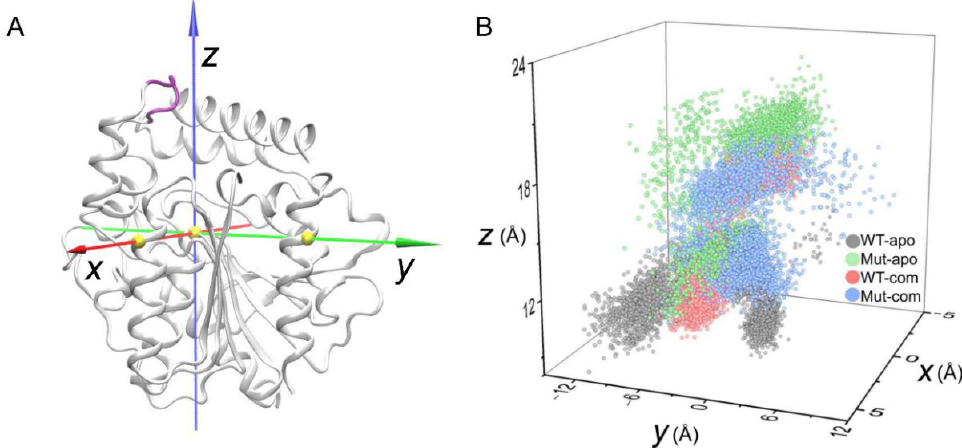
Figure 6. Displacements of the lid region according to the self-defined coordinate system. ( A ) The self-defined coordinate system: the C α atom of S146 is set as the origin, and the x- and y-axes process through the C α atoms of Q244 and D284, respectively. The three C α atoms are shown as yellow spheres. The lid region (C α atoms of residues 192–196, colored in purple) are prepared for vector calculations. ( B ) The plot of the position of the lid region according to the defined coordinate system.